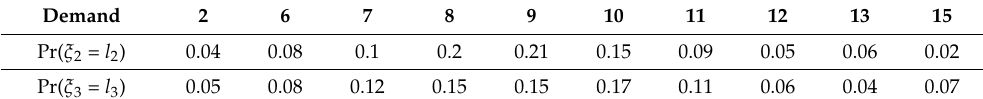
Table 11. Stages 2 and 3 demand distribution (Pr( ξ 2 = l 2 ) and Pr( ξ 3 = l 3 )) forecast in a month.